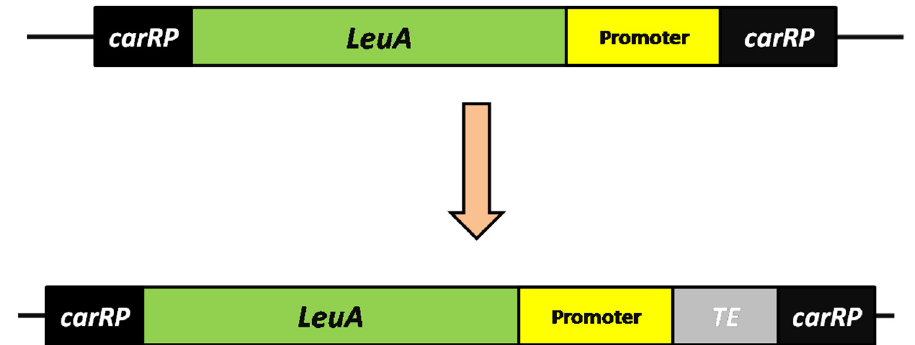
Figure 3. Expression of the TE gene. The structure of plasmid pMAT1552- LeuA -TE for TE gene over-expression in M. circinelloides (MU758) is shown. The grey box indicates the coding region of the acyl-ACP-thioesterase (TE) gene, while the green rectangle of LeuA gene indicates a selectable marker, and the flanking sequences correspond to regions surrounding the carotenogenic carRP gene (black boxes) to allow its chromosomal integration by homologous recombination.